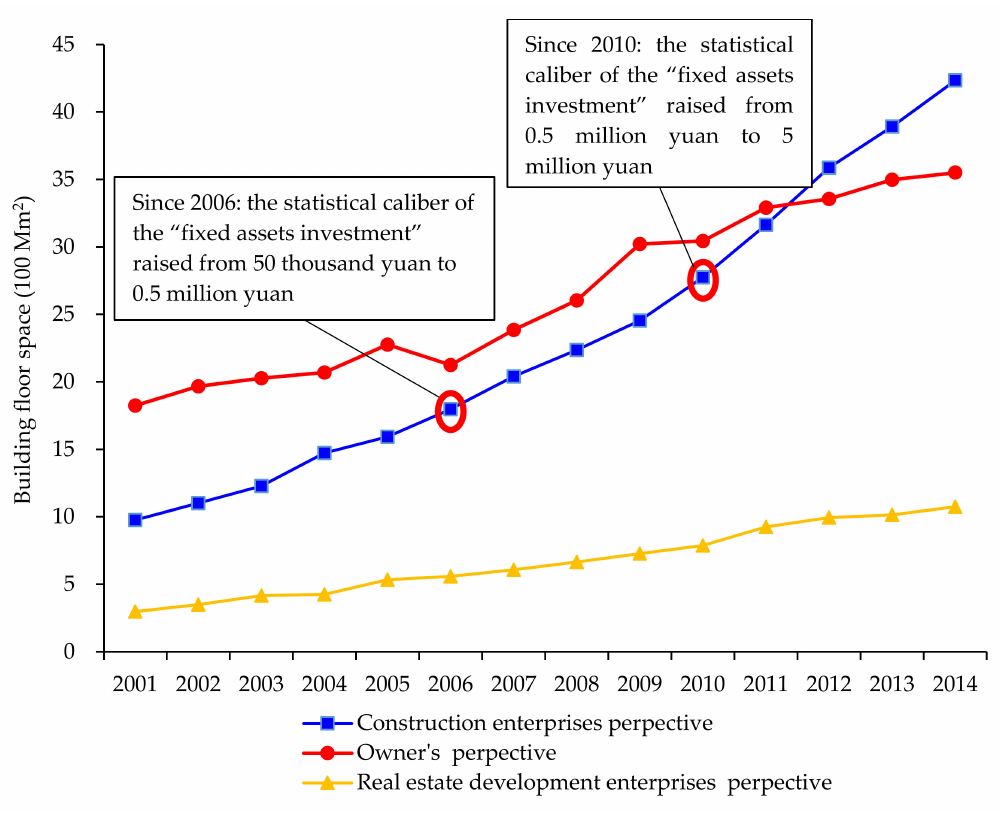
Figure 3. The changing trend of the floor space of buildings completed in di ff erent calibers throughout the whole country from 2001 to